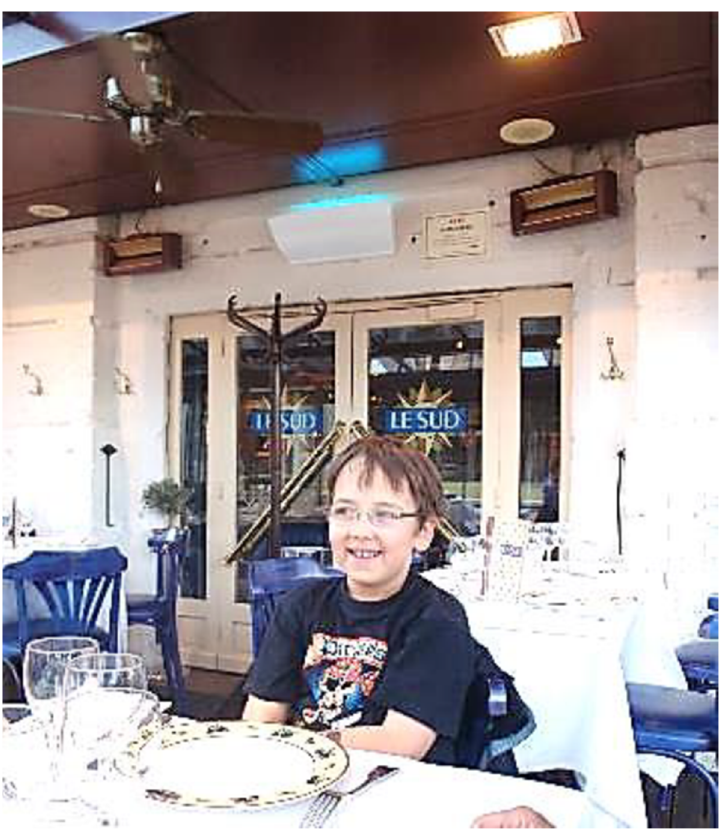
Figure 2. UV light trap mounted high above restaurant entry doors tends to attract flies to the doors with possible entry inside building, Lyon, France.